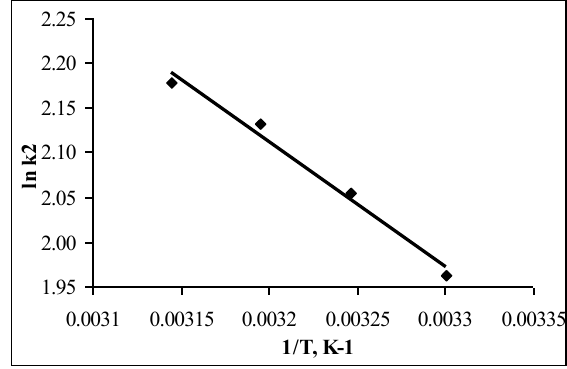
Figure 7 . Arrhenius plot for Adsorption of AO10 onto